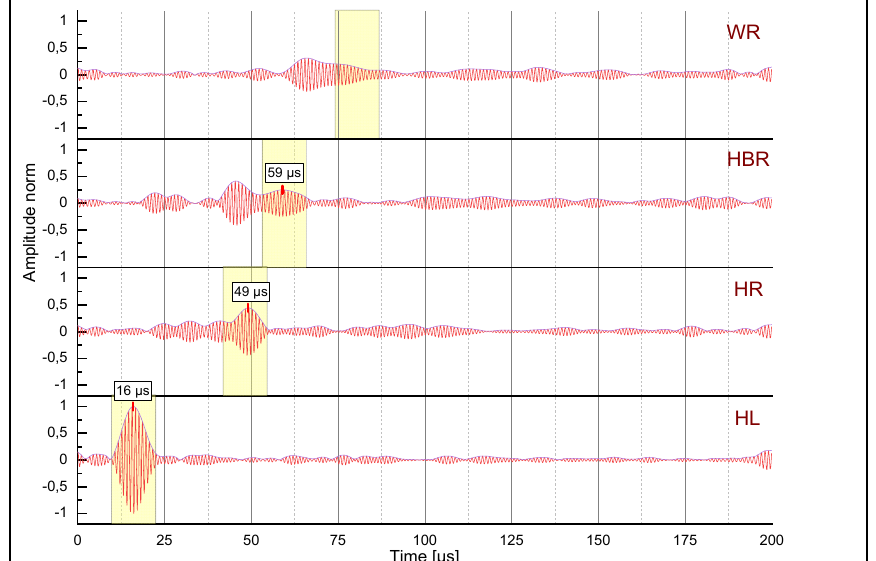
Figure 16. Signals measured along rail circumferential positions (HL, HR, HBR, WR) on the rail with severe head check damage after 310,000 load cycles, normalized with respect to the peak amplitude at position HL.